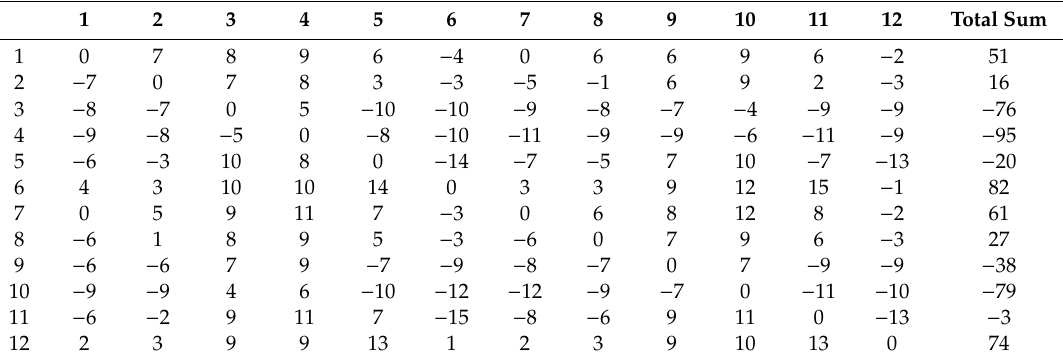
Table 10. Results of the Mann–Whitney U test, the population size is